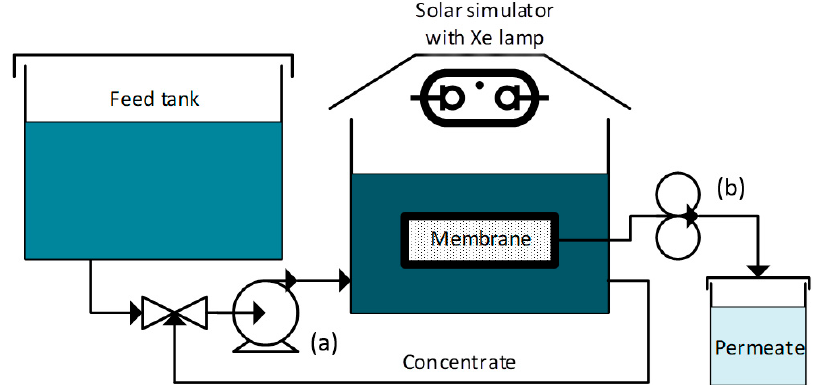
Figure 2. Schematic overview of the experimental set-up, with a recirculating pump ( a ) and a peristaltic pump ( b ), creating a vacuum in the membrane support to generate flow.